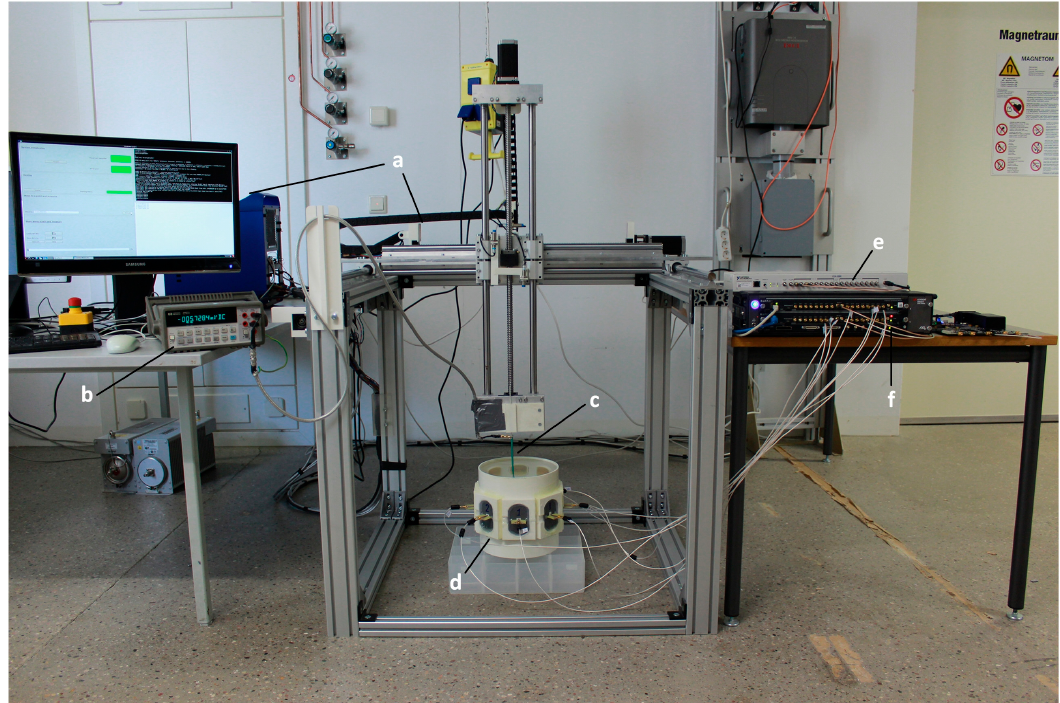
Figure 8. Experimental setup used for E-field mapping. ( a ) the COSI Measure setup, ( b ) digital multimeter (34401A, Keysight) connected to ( c ) the home-built E-field probe, ( d ) 8 SGBT antennae arranged in a circular array (diameter = 22 cm) immersed in deionized water, ( e ) clock distributor, ( f ) RF signal generator. COSI Measure moves the E-field probe with a step size of 2 mm in the central transversal plane of the antennae setup resulting in 6430 measurement